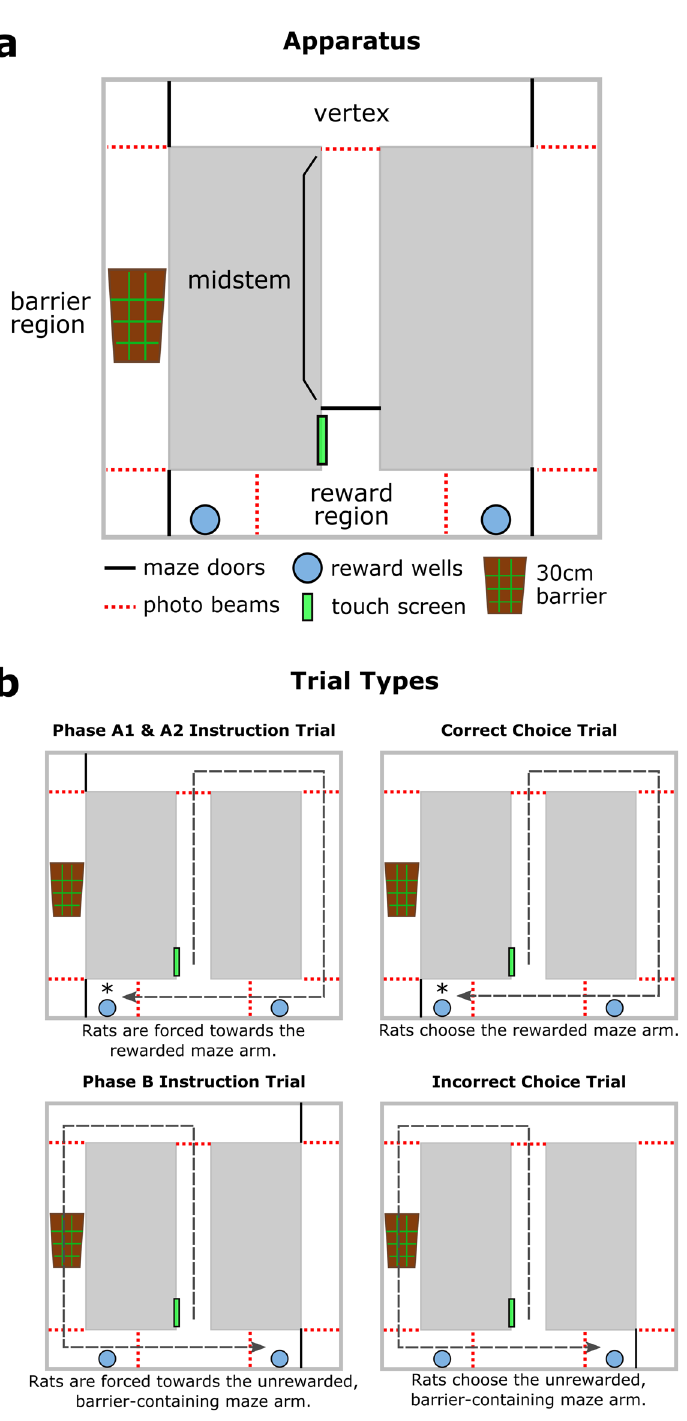
Figure 1. Apparatus ( a ) and task trial-type diagrams ( b ). In ( b ), the asterisk ( * ) indicates the rewarded well. We trained the rats to run all the way through the reward zone to the far reward well so that they were well away from the photobeam-triggered gate which was raised at the completion of each